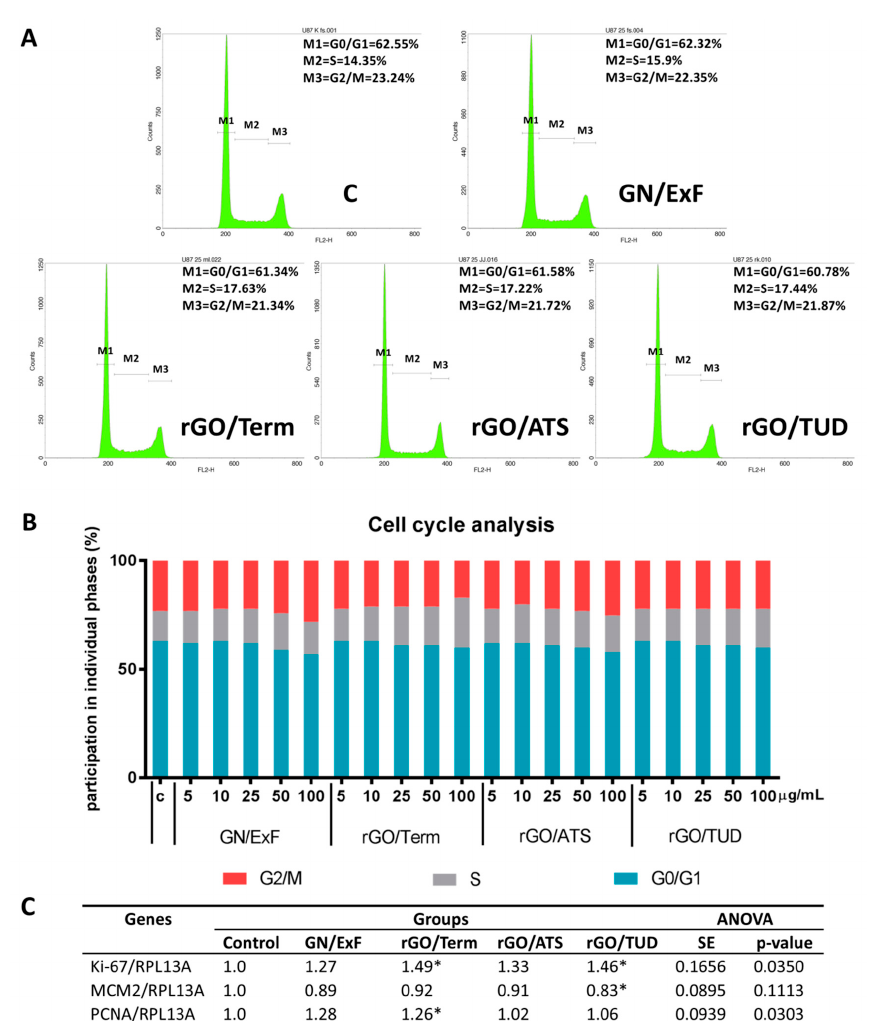
Figure 7. Cell cycle and proliferation in U87 cells untreated and treated with GN and rGO flakes as evaluated by flow cytometry and propidium iodide (PI). ( A ) Histograms were used to analyse the cell cycle in U87 cells untreated and treated with GN or rGO flakes at a concentration of 25 µ g/mL. At 24 h post-treatment, cells were stained with propidium iodide after RNase A treatment and DNA content was evaluated by flow cytometry. Histograms show numerical values of individual phases of the cell cycle. M1 = G0/G1 (G0 indicates cells in the resting phase, while G1 indicates production of mRNA and proteins necessary for DNA synthesis); M2 = S (DNA replication phase); M3 = G2/M (G2 indicates preparing for entry into mitosis, and M indicates the mitotic phase). Histograms on the x-axis show the number of cells collected for analysis, while the y-axis shows the intensity of PI fluorescence on a linear scale. ( B ) Chart shows the percentage of cells in individual phases of the cell cycle at all tested concentrations (5, 10, 25, 50, and 100 µ g/mL) of GN and rGOs. ( C ) Gene expression profile in glioblastoma cell line U87, untreated and treated with graphene (GN) or reduced graphene oxide (rGO) flakes, was assessed using proliferation markers ki-67 , mcm2 , and pcna . Bonferroni’s multiple comparison test was used for statistical analysis. Values in rows marked with an asterisk (*) show statistically significant differences at p -value < 0.005. Values marked with one asterisk (*) indicate p -value < 0.005. Values were normalized to that of the reference hose-keeping gene rpl13a . The expression level of the examined genes was expressed as the relative quantitation (RQ) value. Abbreviations : C, control group (untreated cells); rGO, reduced graphene oxide; GN, graphene; ki-67 , nuclear protein detected using monoclonal antibody Ki-67; mcm2 , minichromosome maintenance complex component 2; pcna , proliferating cell nuclear antigen; ANOVA, analysis of variance; rpl13a , ribosomal protein L13a; SE, standard